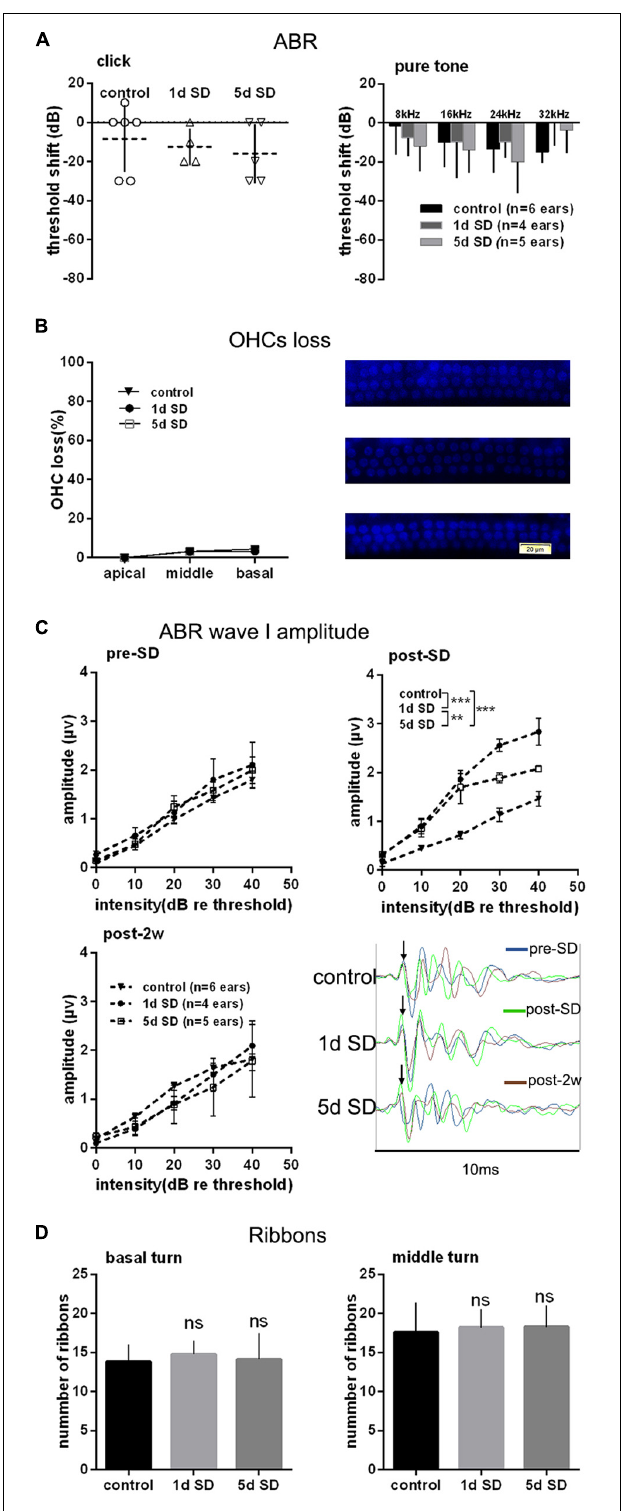
FIGURE 2 | Audiometric threshold shifts, quantification of outer hair cells (OHCs) and inner hair cell (IHC) ribbons at post-2w, and ABR wave I amplitude for SD groups and control group. (A) Mean (transverse line) ± S.D.